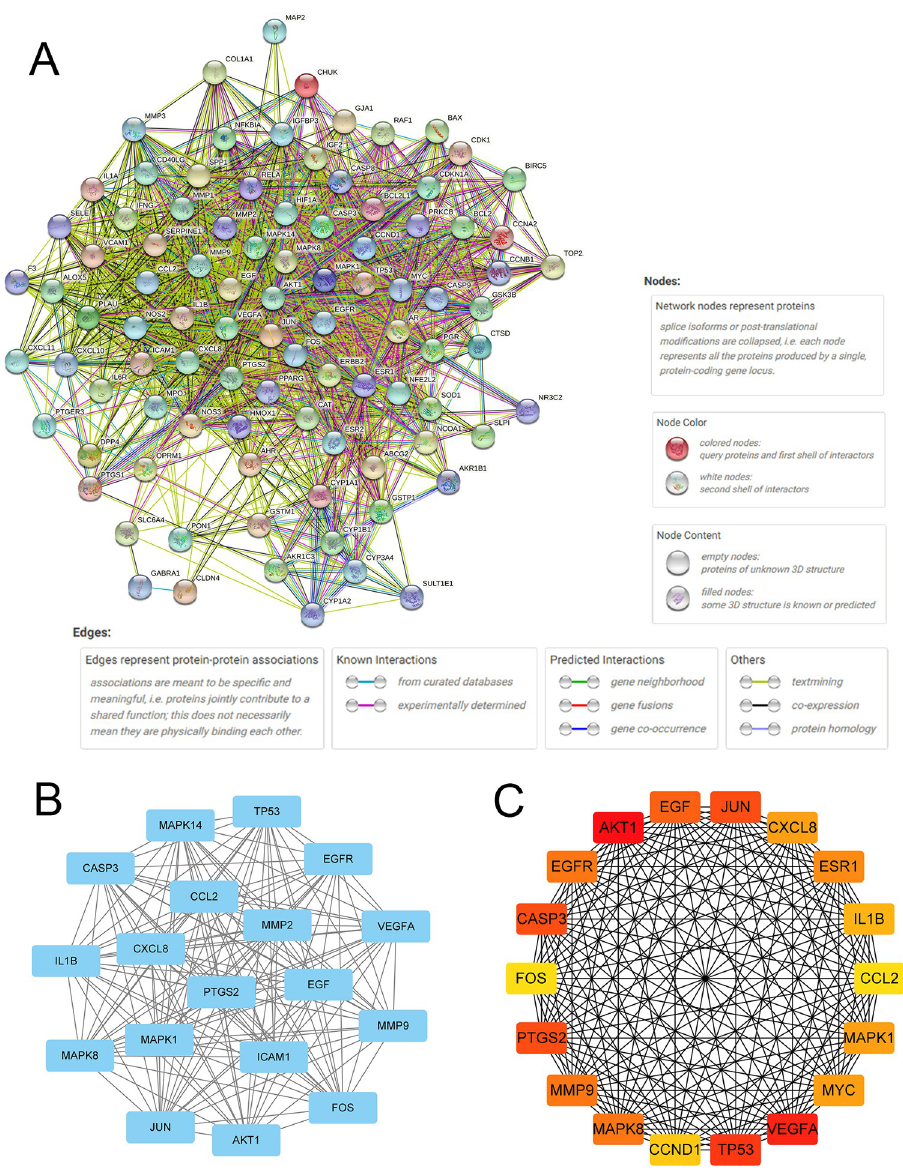
Fig 5. Protein–protein interaction (PPI) network and key subnetworks by Cytoscape. (A) PPI network exported from the STRING database and some annotations. (B) Key subnetwork screened after two filtrations using CytoNCA. (C) Key subnetwork of the top 18 nodes analyzed by